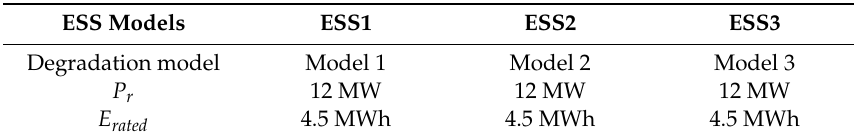
Table 10. Life model setting by ESS.